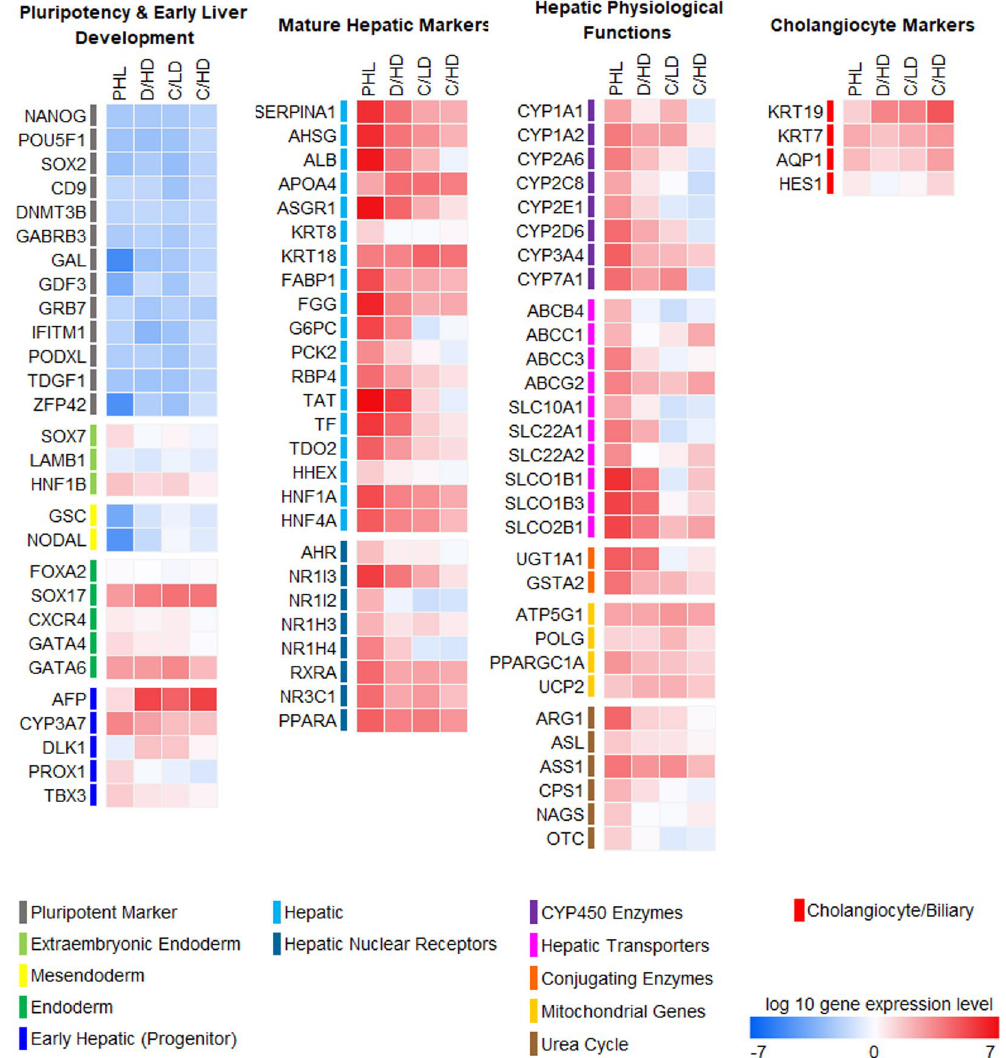
Figure 5. Comprehensive gene expression analysis of hiPSC-derived liver organoids (HLOs) and primary human liver (PHL). All expression levels demonstrated a relative expression level against the undifferentiated hiPSCs. The HLOs generated in D/HD conditioned medium showed a higher gene expression tendency of the hepatic-related markers than C/LD and C/HD. Additionally, the highest expression of cholangiocytes marker was detected in HLOs generated using C/HD (n = 6 biologically independent